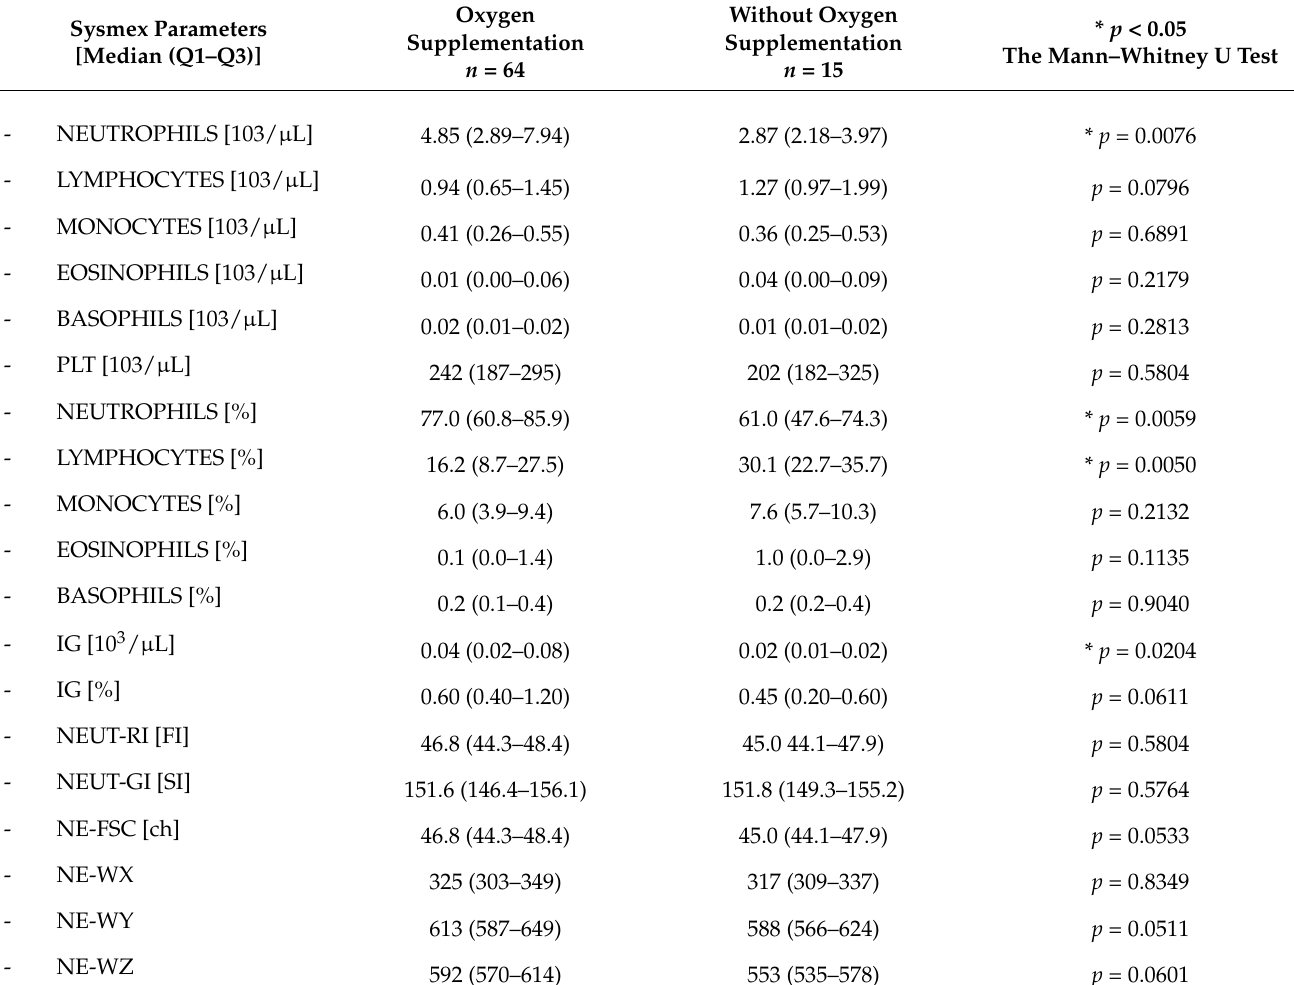
Table 5. Proportion of basic morphological Sysmex parameters and new parameters connected with neutrophils in COVID- 19 patients with oxygen supplementation and without oxygen supplementation. Data expressed as median (Q1–Q3). A * indicates p statistically